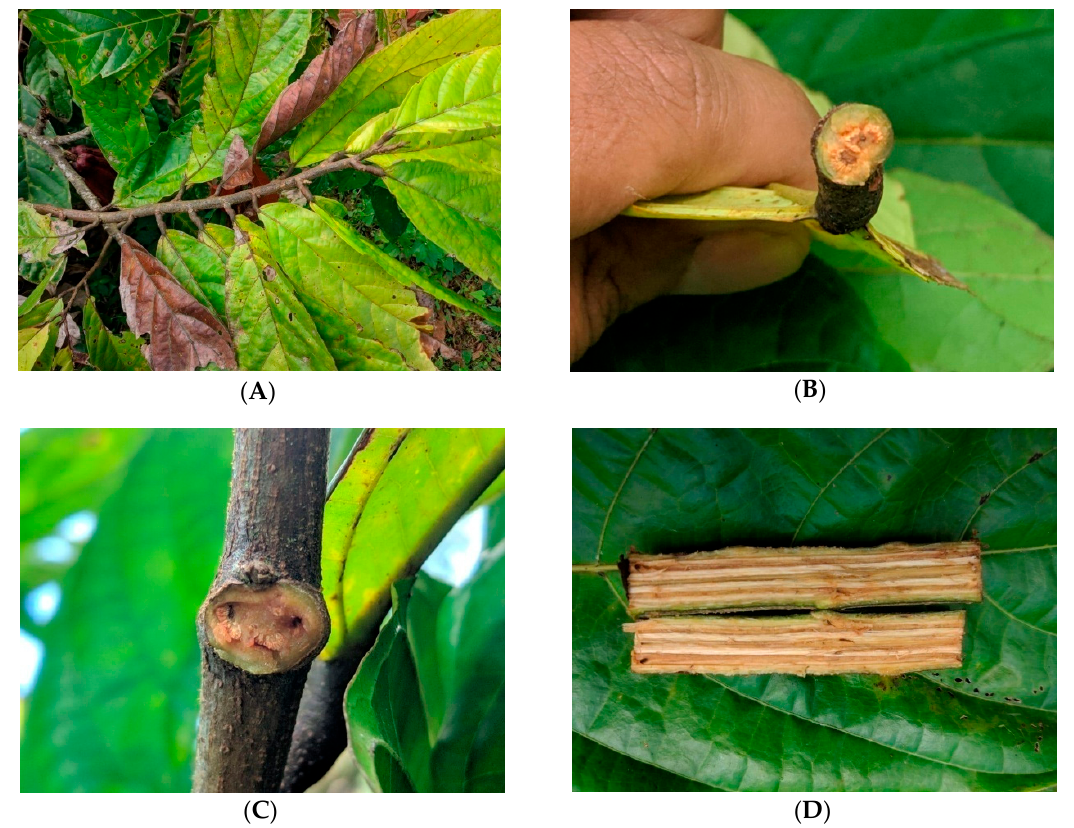
Figure 1. Symptoms of vascular streak dieback (VSD) disease. Full-leaf chlorosis and necrosison a branch ( A ) discoloration of vascular traces on petioles ( B ), on leaf scars ( C ), and in wood ( D ).